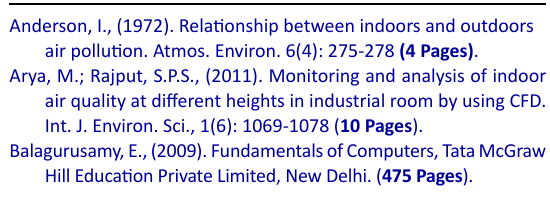
very much desired and tried. Optima 7 gas analyser was used to validate the IoT device monitored air quality data. Optima 7 gas analyser and IoT device were fixed at same location (Avadi) and data were collected (Table 3) from both device for